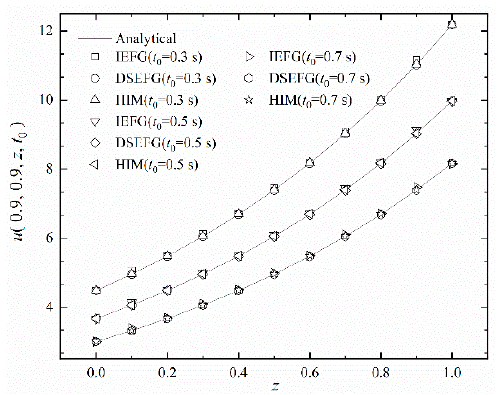
is different. is different. 0 0